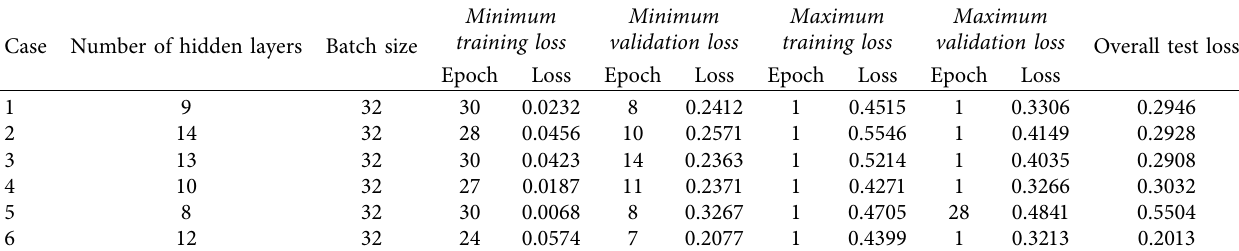
Table 2: Loss of the CNN for the six diferent cases for various hidden layers. Case Number of hidden layers Batch